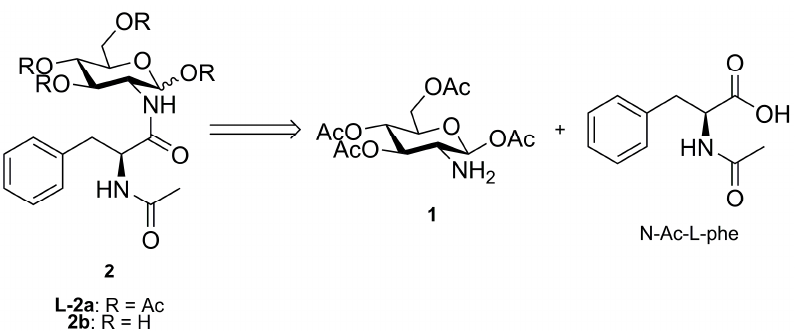
Figure 1. Retrosynthesis for NAPA ( 2b ) or its tetra- O -acetylated precursor ( L-2a ) from 1,3,4,6-tetra- O -acetyl- β - D -glucosamine ( 1 ) and N -acetyl- L -phenylalanine ( N -Ac- L -phe).